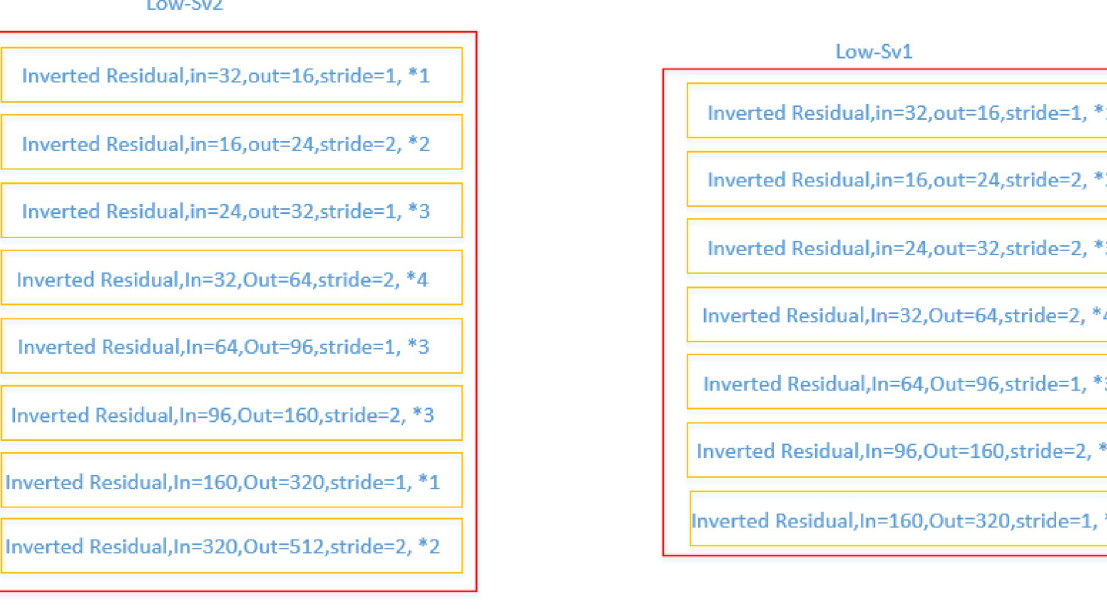
Fig 3. Low-Sv1 and Low-Sv2 network